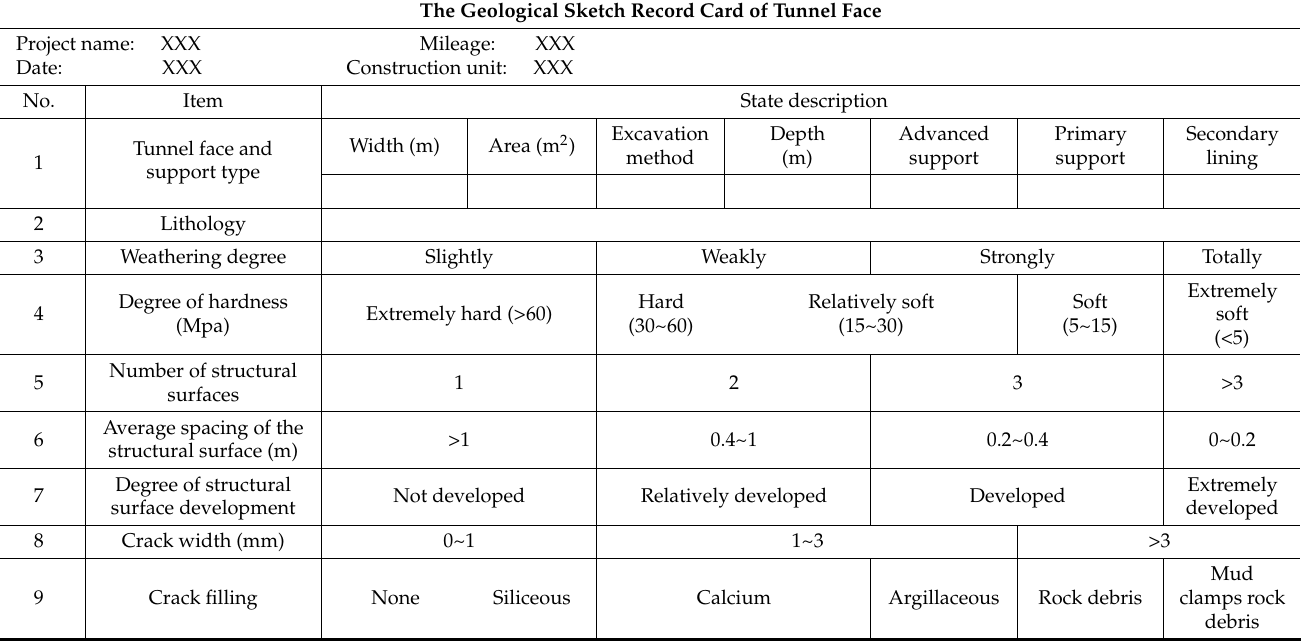
Table 2. Geological sketch record card of the tunnel